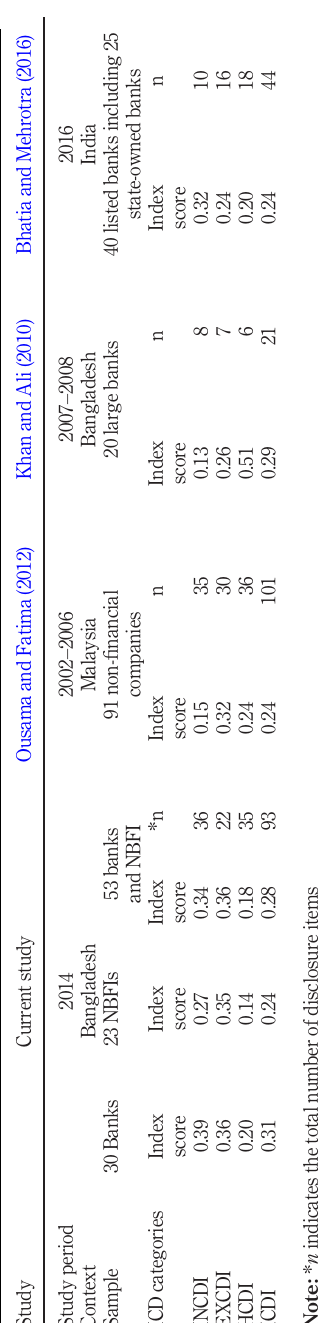
analysis of ICDI of prior